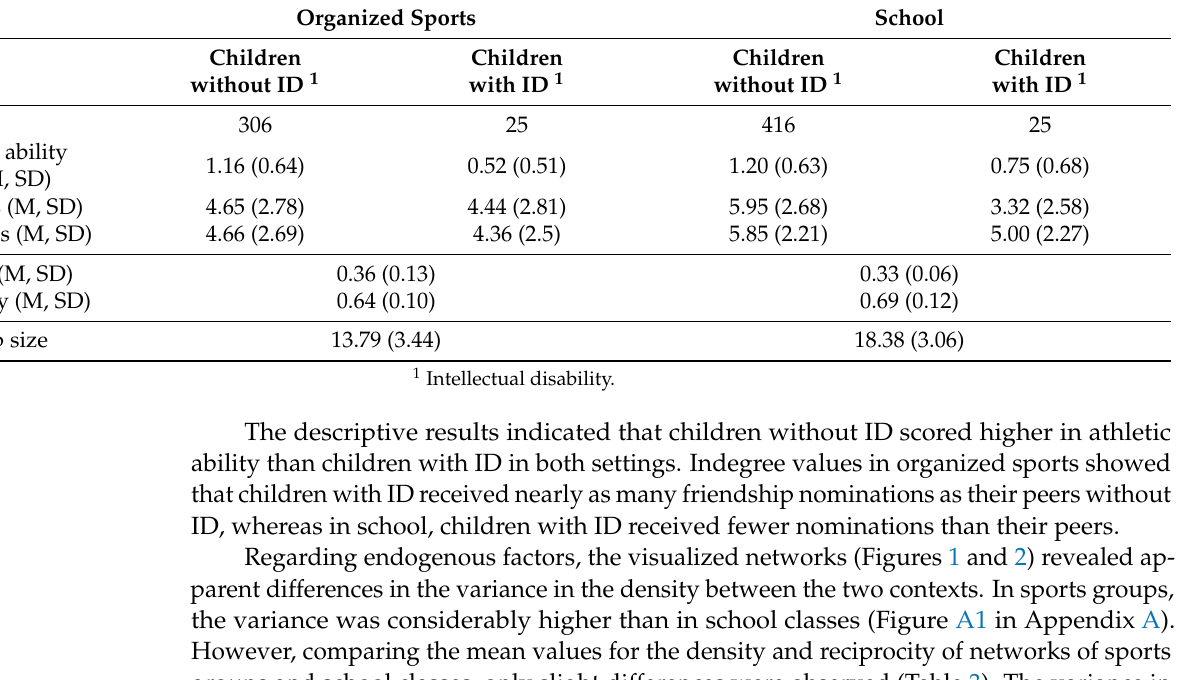
Table 3. Descriptive results (N = 24 sports groups, N = 24 school